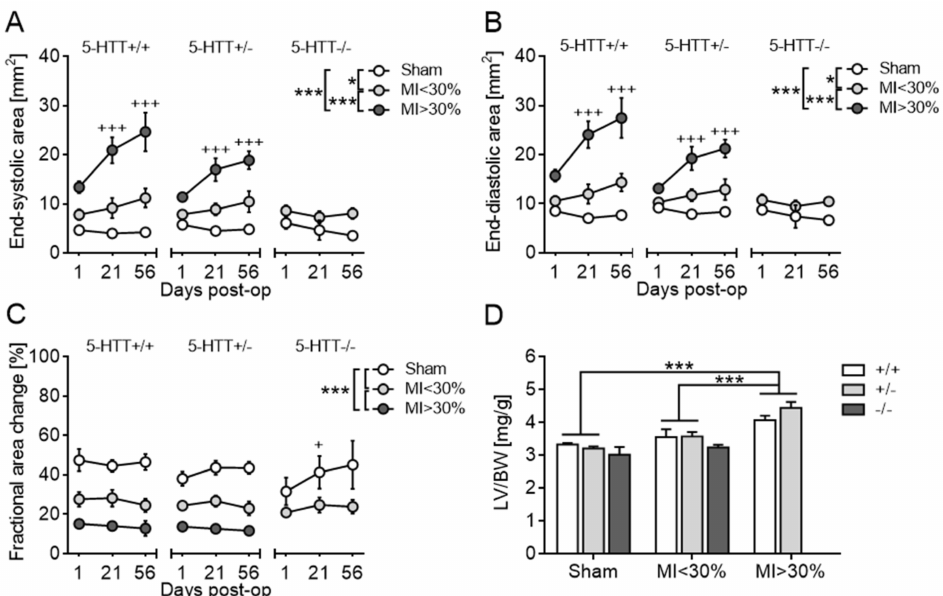
Figure 4. Development of left ventricular failure and hypertrophy after MI in mice. ( A – C ) Assessment of left ventricular dimensions and function by serial echocardiography on postoperative days 1, 21 and 56. Irrespective of 5-Htt genotype, MI mice exhibited a time- and infarct size-dependent increase in end-systolic area ( A ) and end-diastolic area ( B ) and a persistent reduction in fractional area change ( C ) as compared to sham controls, indicating progressive LV dilatation and dysfunction due to heart failure. ( D ) Analysis of left ventricle-to-body weight (LV/BW) ratio as an index of cardiac hypertrophy revealed significant enlargement in MI > 30% mice relative to MI < 30% and sham animals at 8 weeks post-op. Data are shown as mean ± SEM. * p < 0.05 and *** p < 0.001 for comparisons between groups; + p < 0.05 and +++ p < 0.001 compared to day 1; ( A – C ) three-way mixed ANOVA and ( D ) ordinary two-way ANOVA followed by Sidak or Tukey multiple comparisons